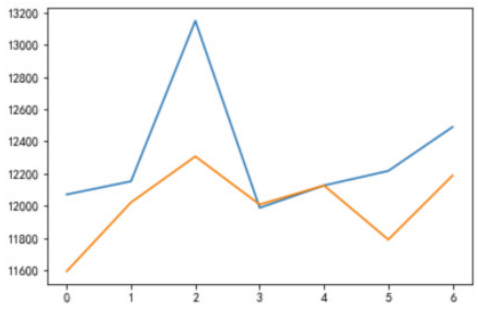
Figure 8. A350 fuel consumption forecast.